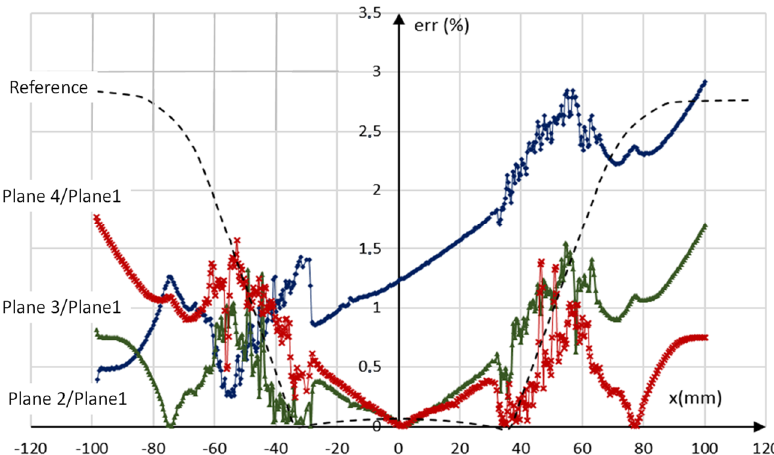
Figure 11. Relative profile error compared to the profile along to the plane 1 for h = 40 mm.